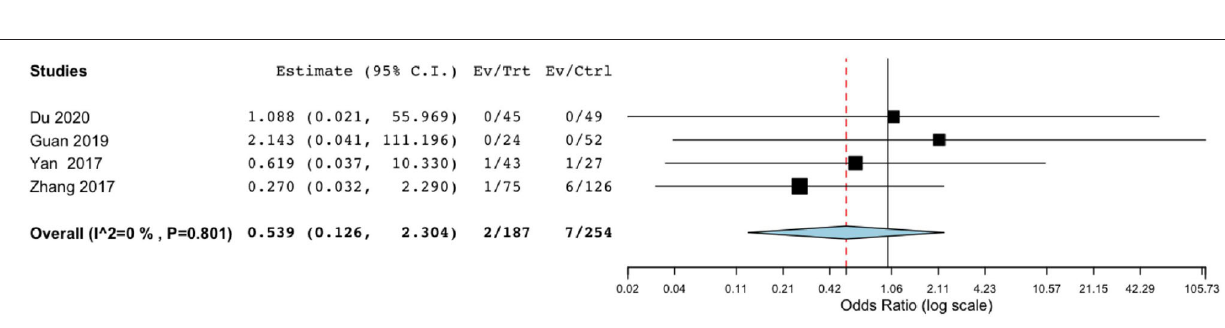
FIGURE 4 | Risk of postoperative mortality in endoscope-assisted surgery and BHC groups. (OR of 0.539, 95%CI, 0.126–2.304, P = 0.404, I 2 = 0 %